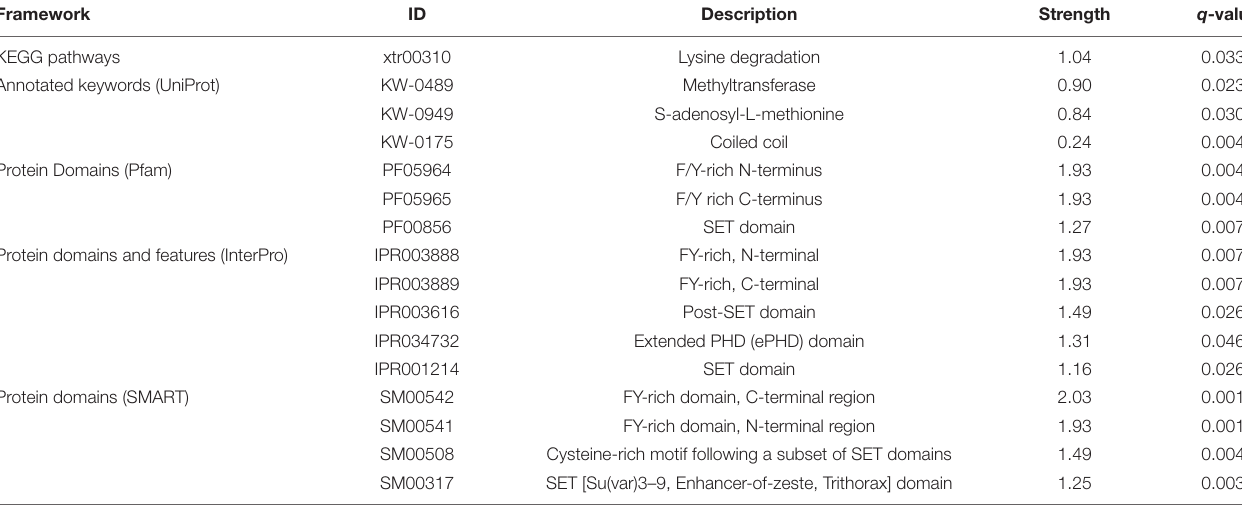
TABLE 1 | Results of STRING functional enrichment analyses based on combined dataset of upregulated and downregulated proteins. Framework